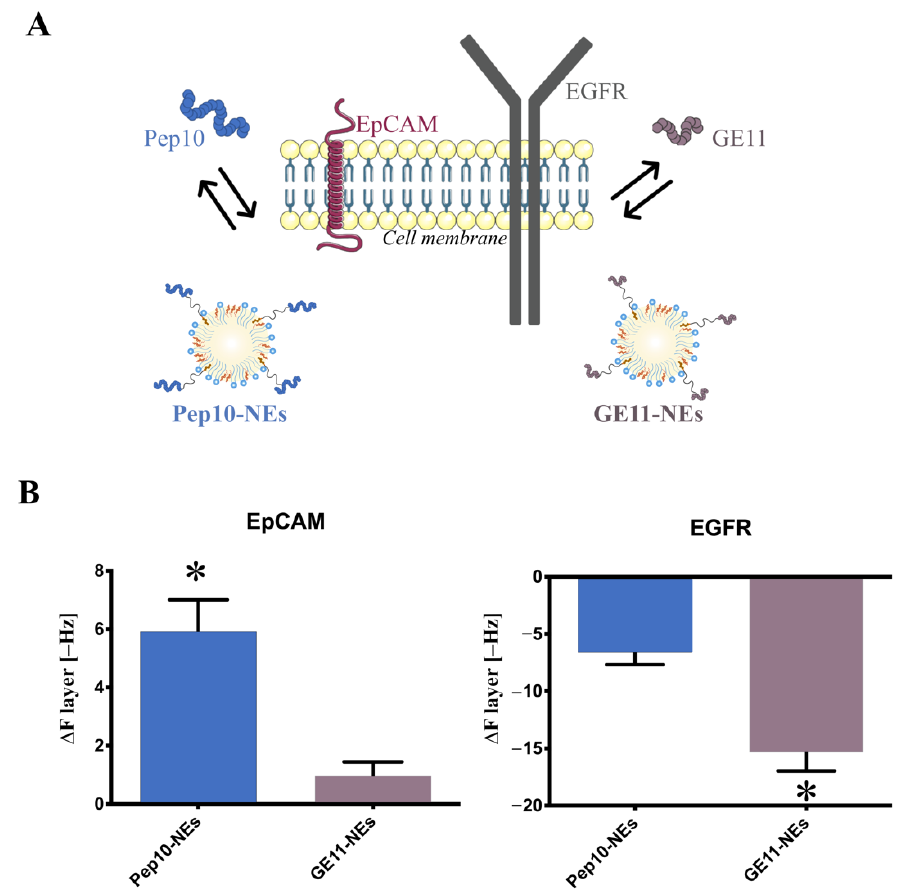
Figure 5. Specific binding analysis of Pept-NEs at the protein level . ( A ) Diagram of targeting abilities of Pept-NEs (Pep10-NEs and GE11-NEs), ligands (GE11 and Pep10 peptides) and their receptors (EGFR and EpCAM), respectively. ( B ) QCM-D frequency changes upon binding of proteins (EpCAM and EGFR) to Pept-NEs (Pep10-NEs and GE11-NEs). Values represent mean ± SD ( n = 2). Statical differences are represented as * ( p < 0.05).